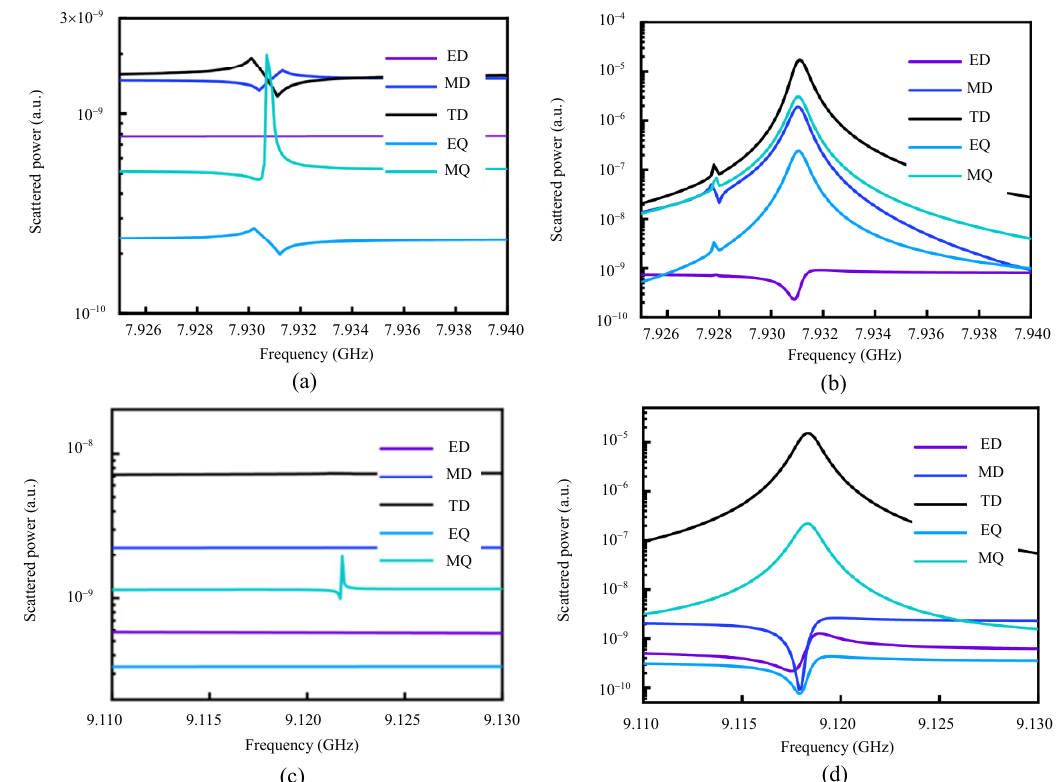
Fig. 4 Multipole decomposition of modes: (a) and (b) multipole decomposition of Mode 1 ( P =0 and P =0.5 mm); (c) and (d) multipole decomposition of Mode 2 ( P =0 and P =0.5